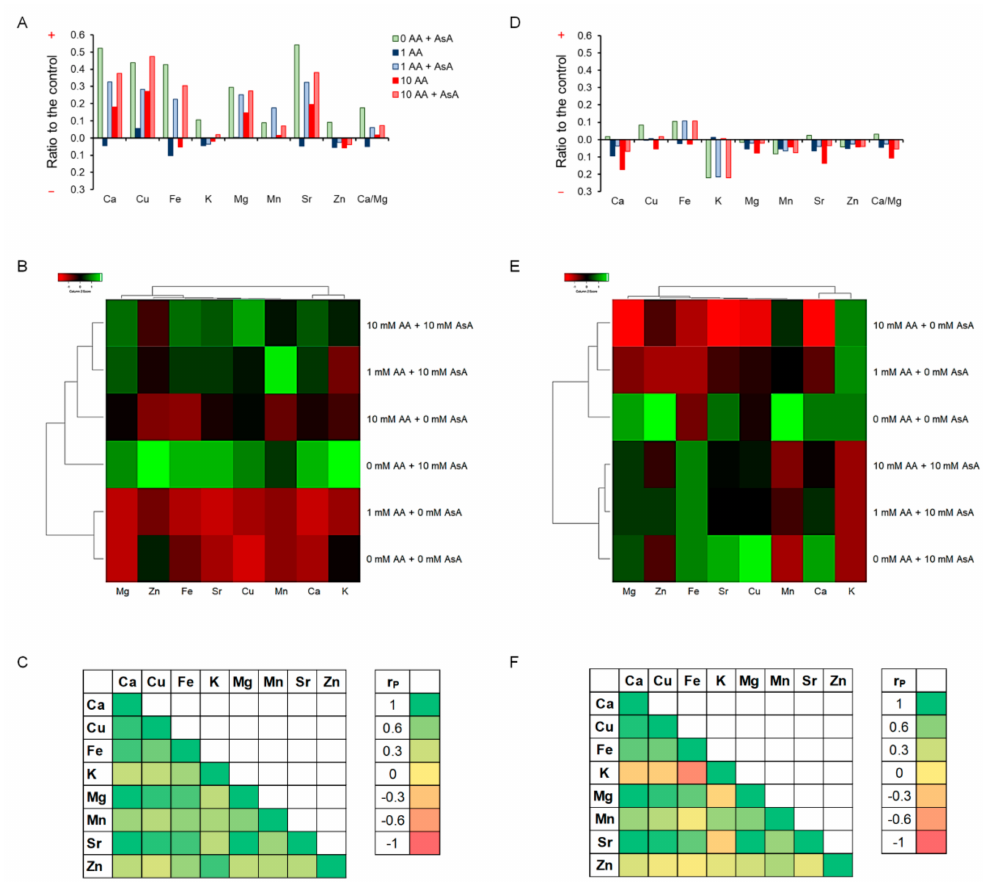
Figure 9. AA mediates disruption of the ionome balance. Differences of the ion content upon treatment are compared to the untreated control after 3 h ( A ) and 9 h ( D ) of incubation and expressed as increase (+) or decrease ( − ) relative to the control. Control is set up as 0.0 on the x axis. Z-score clusters of variables to adjust for the differences in magnitude between different ions after 3 h ( B ) and 9 h ( E ) of incubation. Correlation analyses of mutual ion interactions by Pearson test (r P ) after 3 h ( C ) and 9 h ( F ) of